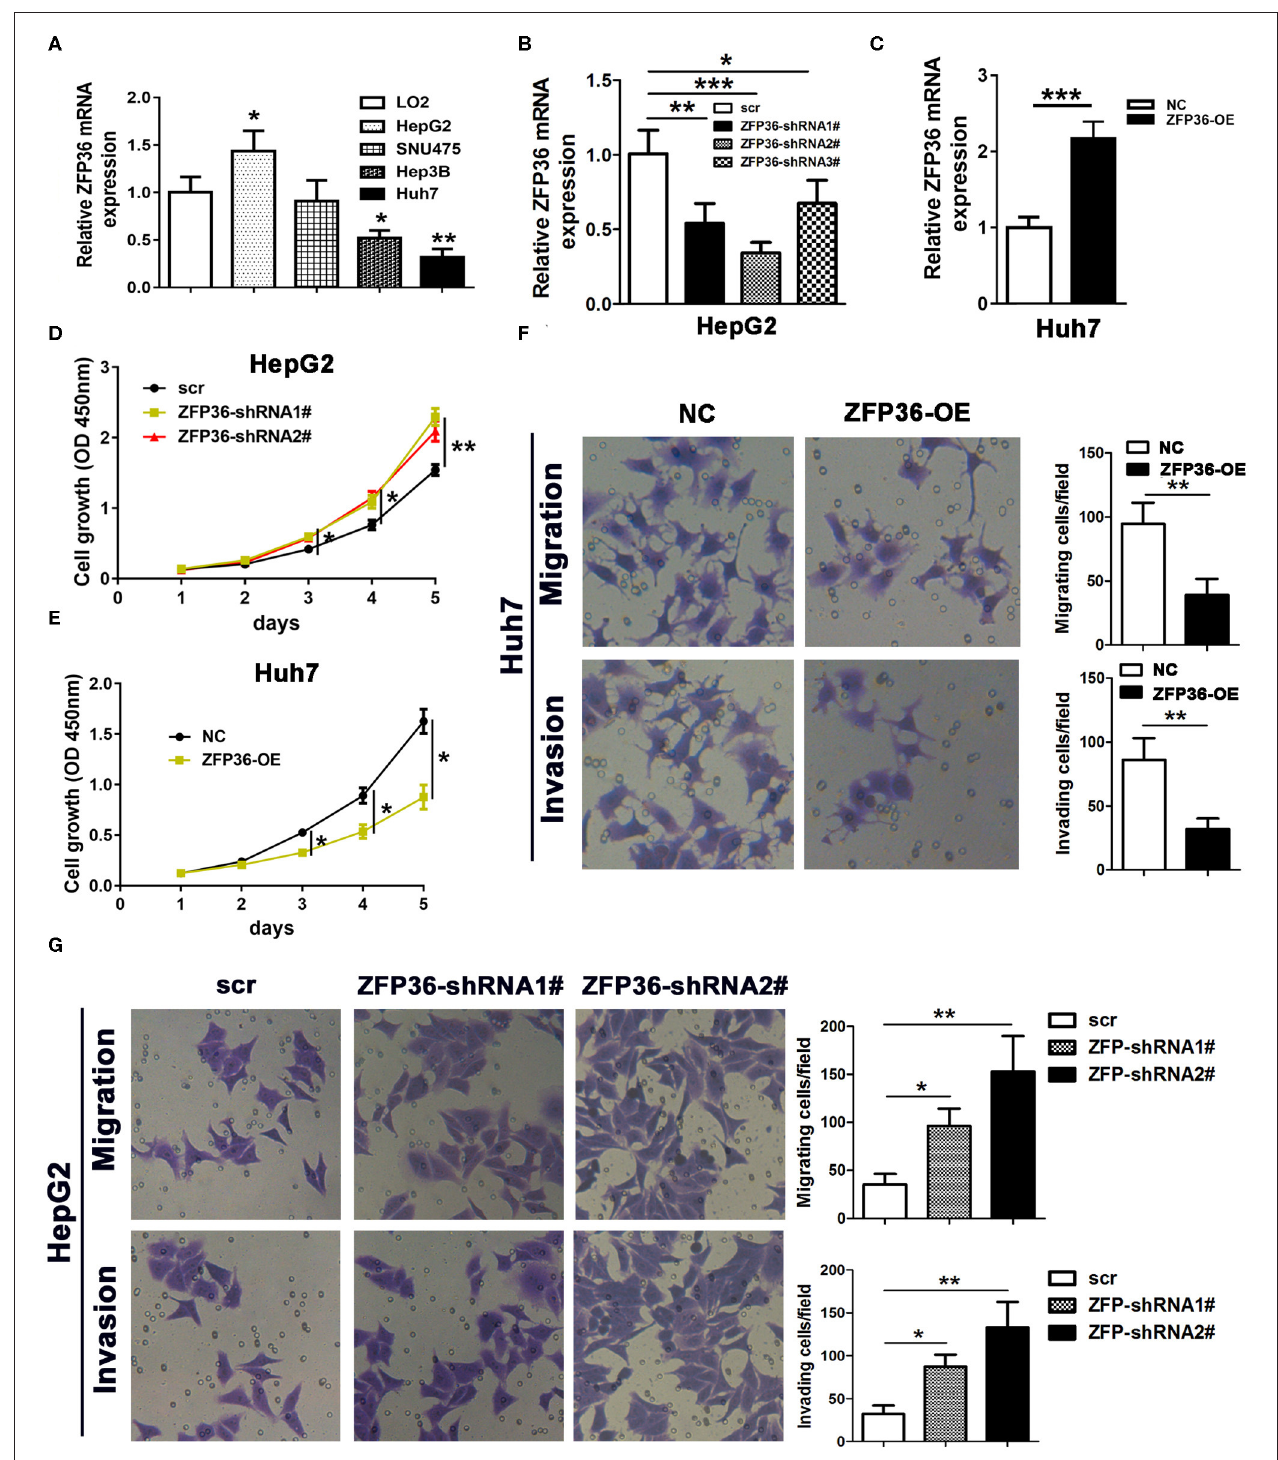
FIGURE 2 | ZFP36 regulates cell growth and cell migration and invasion. (A) qRT-PCR analysis of ZFP36 expression in the hepatocellular carcinoma cell lines HepG2, SNU475, Hep3B, and Huh7 and the normal liver cell line LO2. (B) Knockdown of ZFP36 (ZFP36 shRNA1# − 3#) in HepG2 cells and qRT-PCR assessment of ZFP36 expression. HepG2 cells were transfected with ZFP36-shRNA1# or shRNA2# and Huh7 cells were transfected with ZFP36-OE for ZFP36 overexpression. (C) Overexpression of ZFP36 in Huh7 cells and qRT-PCR assessment of ZFP36 expression. (D,E) Cell growth was determined by the CCK-8 assay. (F,G) cell migration and invasion were detected by Transwell assay. * p < 0.05, ** p < 0.01, *** p < 0.001.